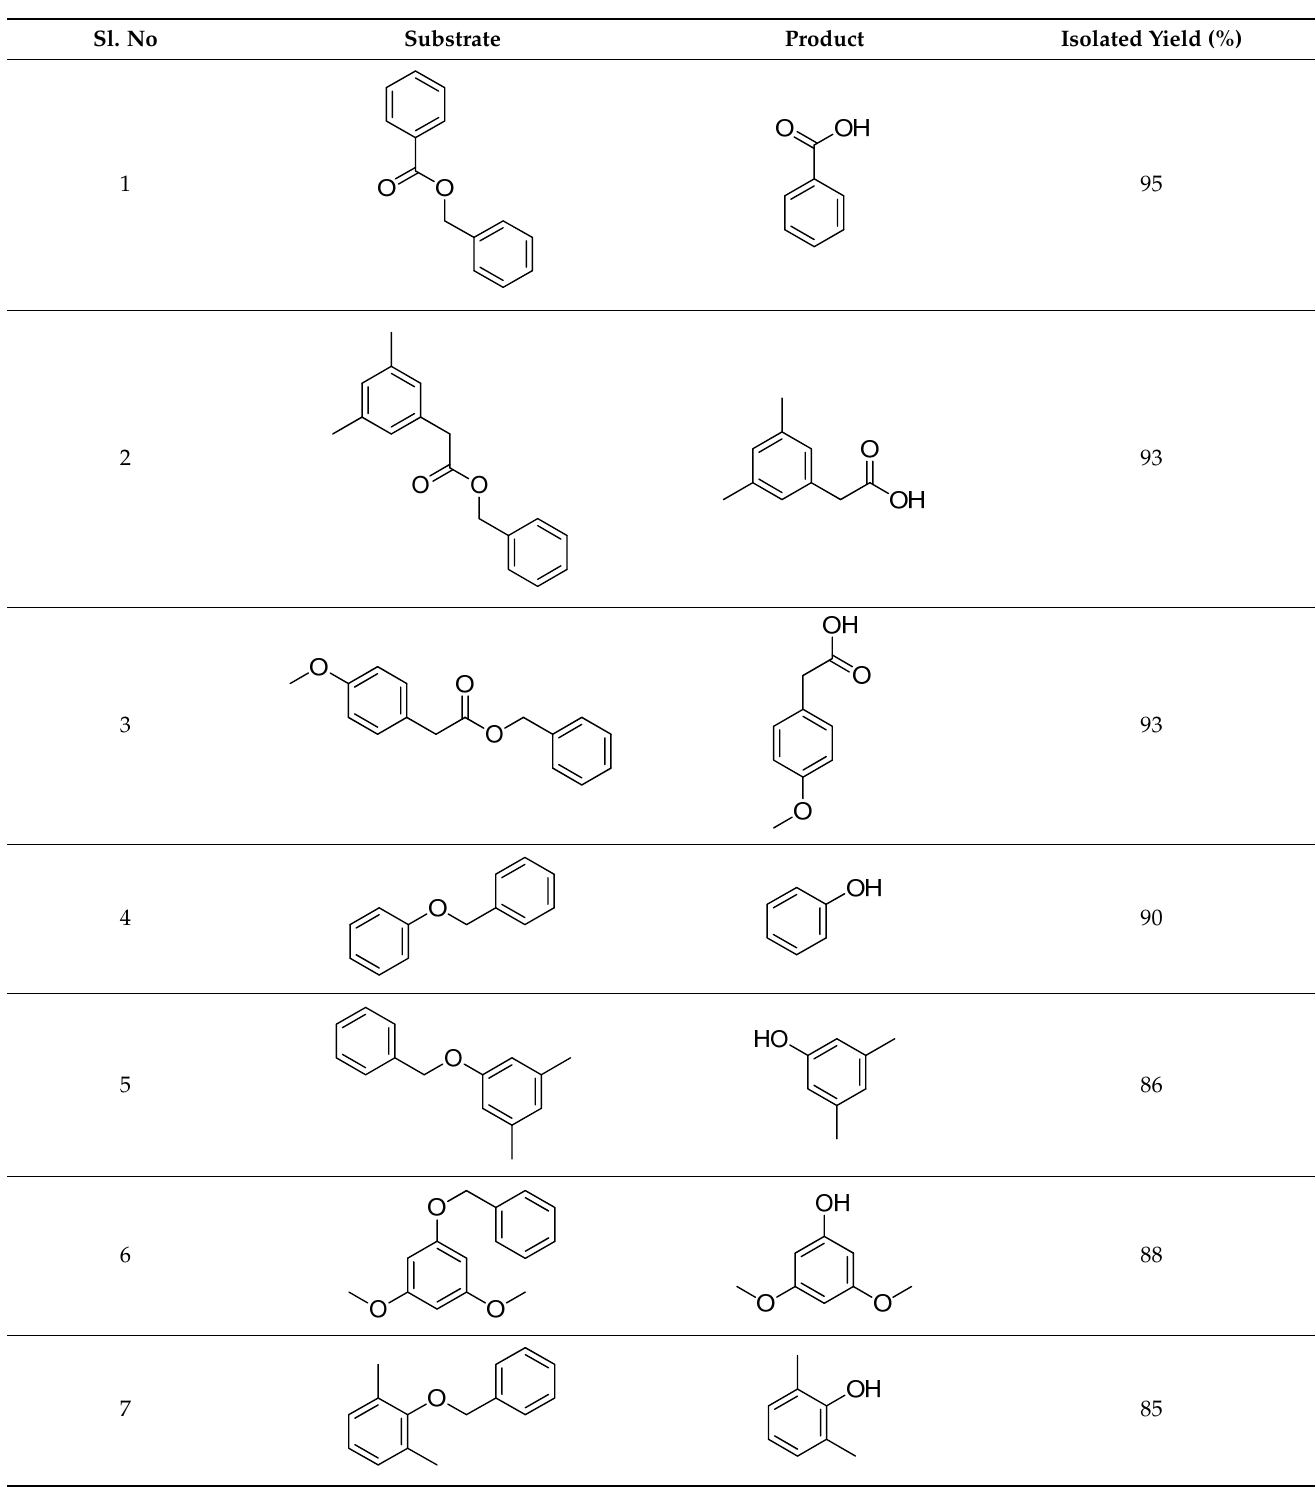
donor, we validated our protocol with several categories of substrates. Several examples of benzyl protected acid and alcohol group carrying different functionalities were hy ‐ by the TEM (Figure S4 and Table S4), SEM (Figure S5 and Table S5), and XPS (Table S6) drodebenzylated in presence of Ru ‐ GCN catalyst. The experimented results are depicted analysis. Therefore, it is clear that our developed Ru-GCN catalyst has good activity as in the Table 2. well as stability after multiple cycles. Table 2. Substrate scope for the Ru ‐ GCN catalyzed hydroddebenzylation reaction. Table 2. Substrate scope for the Ru-GCN catalyzed hydrodebenzylation reaction. Table 2. Substrate scope for the Ru ‐ GCN catalyzed hydroddebenzylation Sl. No Substrate Sl. No Substrate Product Isolated Yield (%)